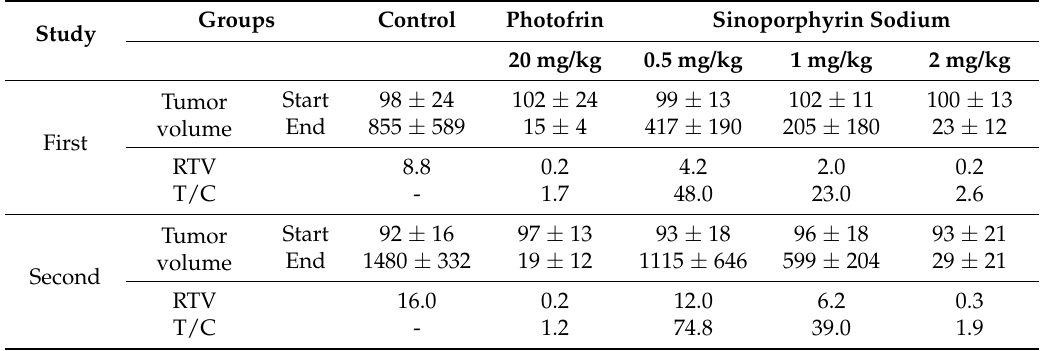
Table 3. Tumor volumes, RTV and T/C values in esophagus tumor CaEs-17 xenograft experiments.